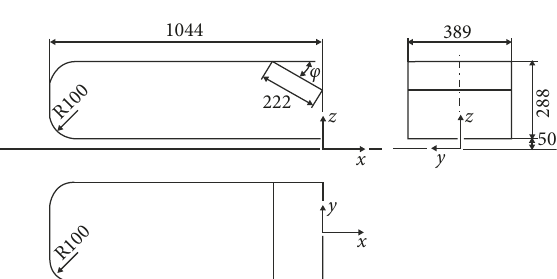
Figure 1: Ahmed body.